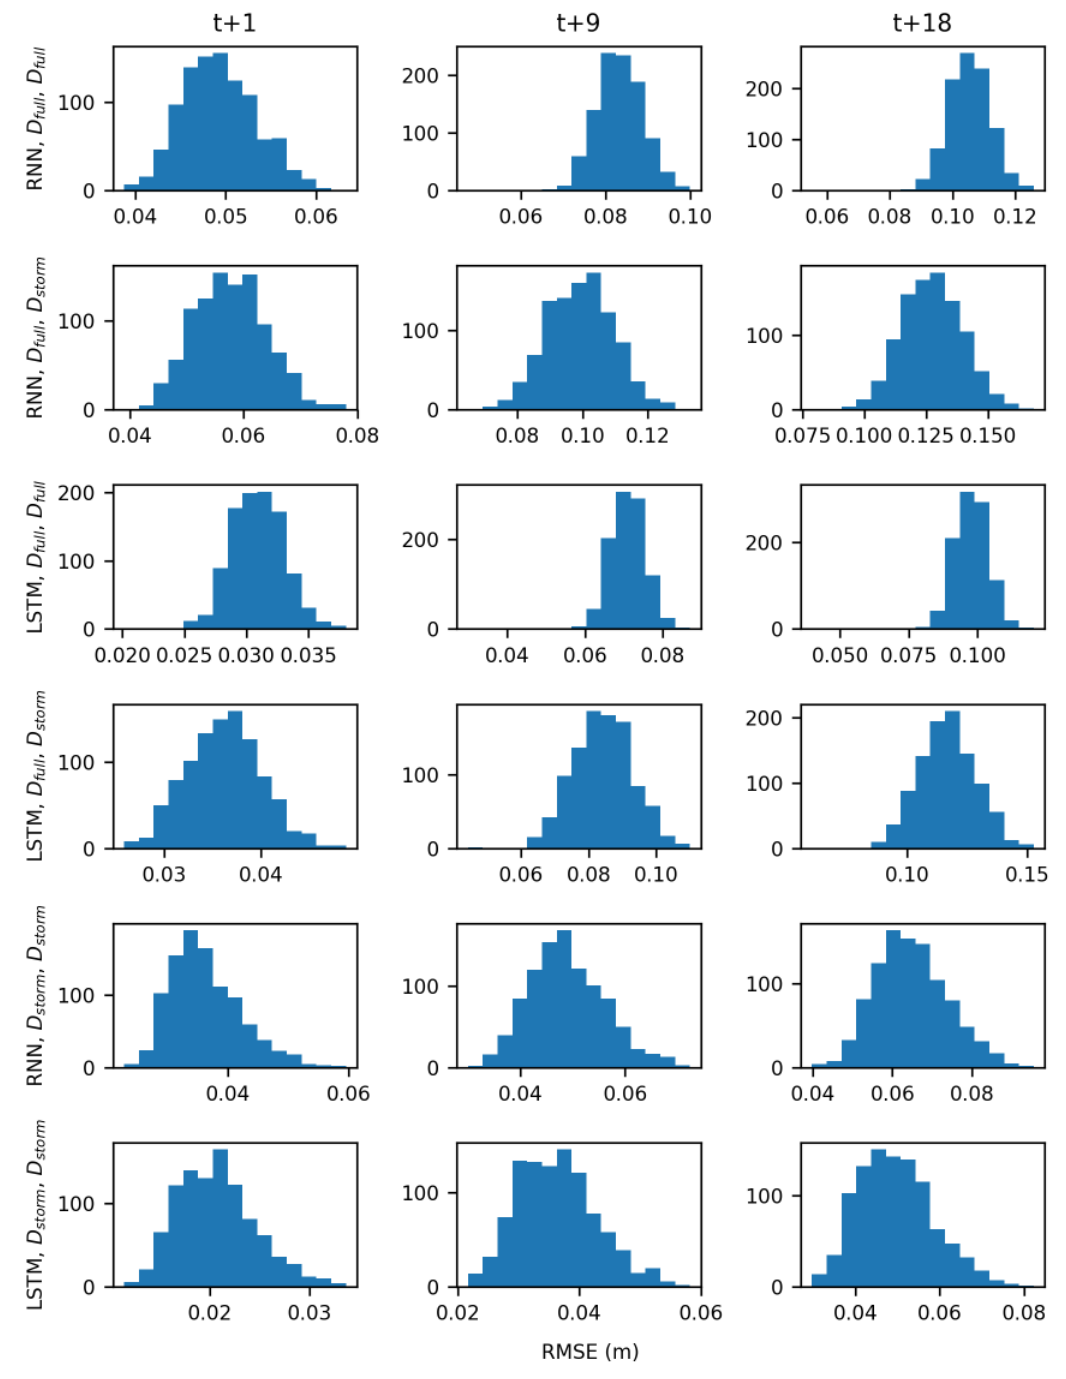
Figure A7. RMSE distributions for GW7 using observed data. Columns represent the forecast horizons t + 1, t + 9, and t + 18. Rows are specified as model type, training data, and testing data.